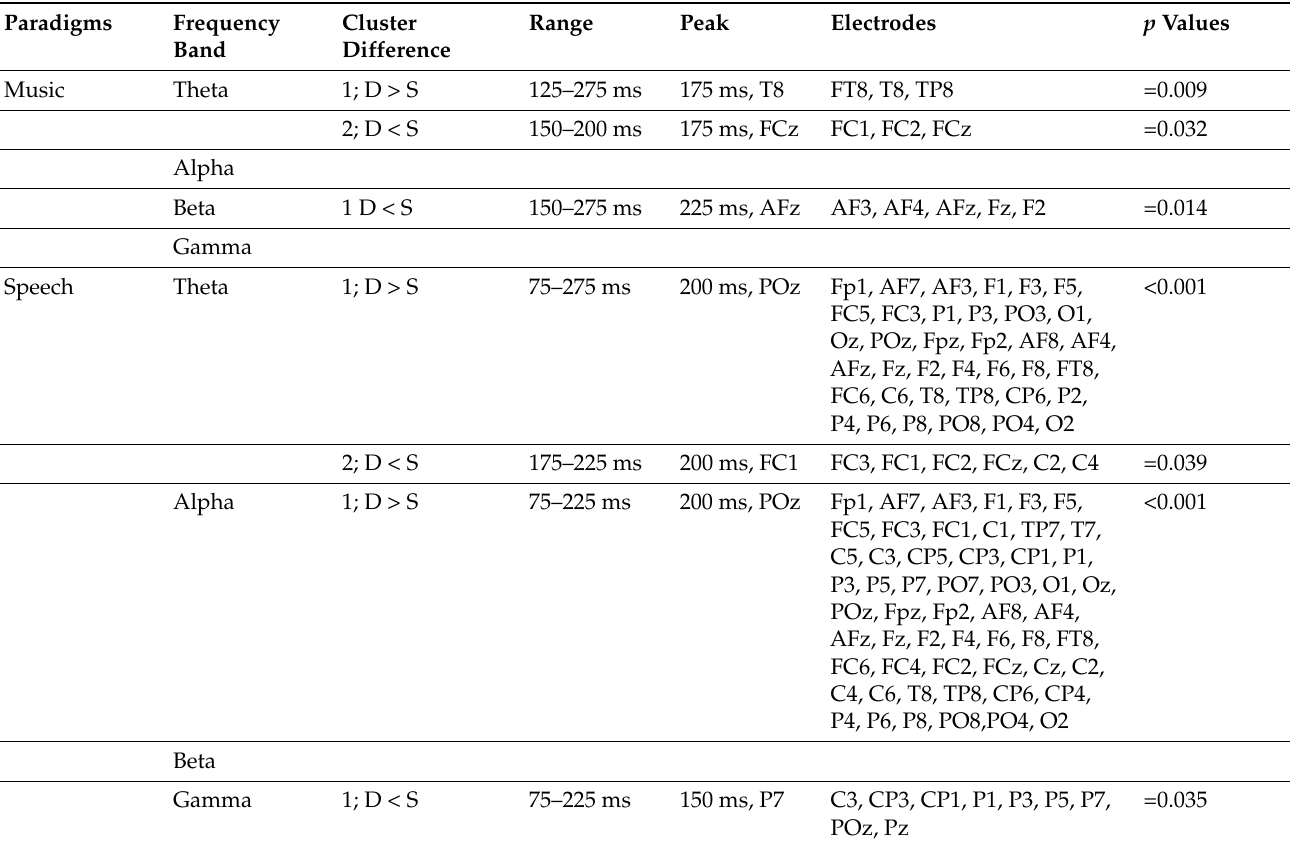
Table 3. Results from the clustered-statistic comparing oscillatory activity elicited by deviant and standard stimuli from the music and speech oddball paradigm before the